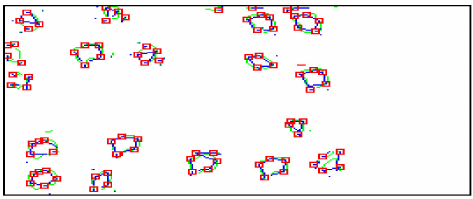
Figure 6. Result of the vectorization of the steel ladle thermogram.